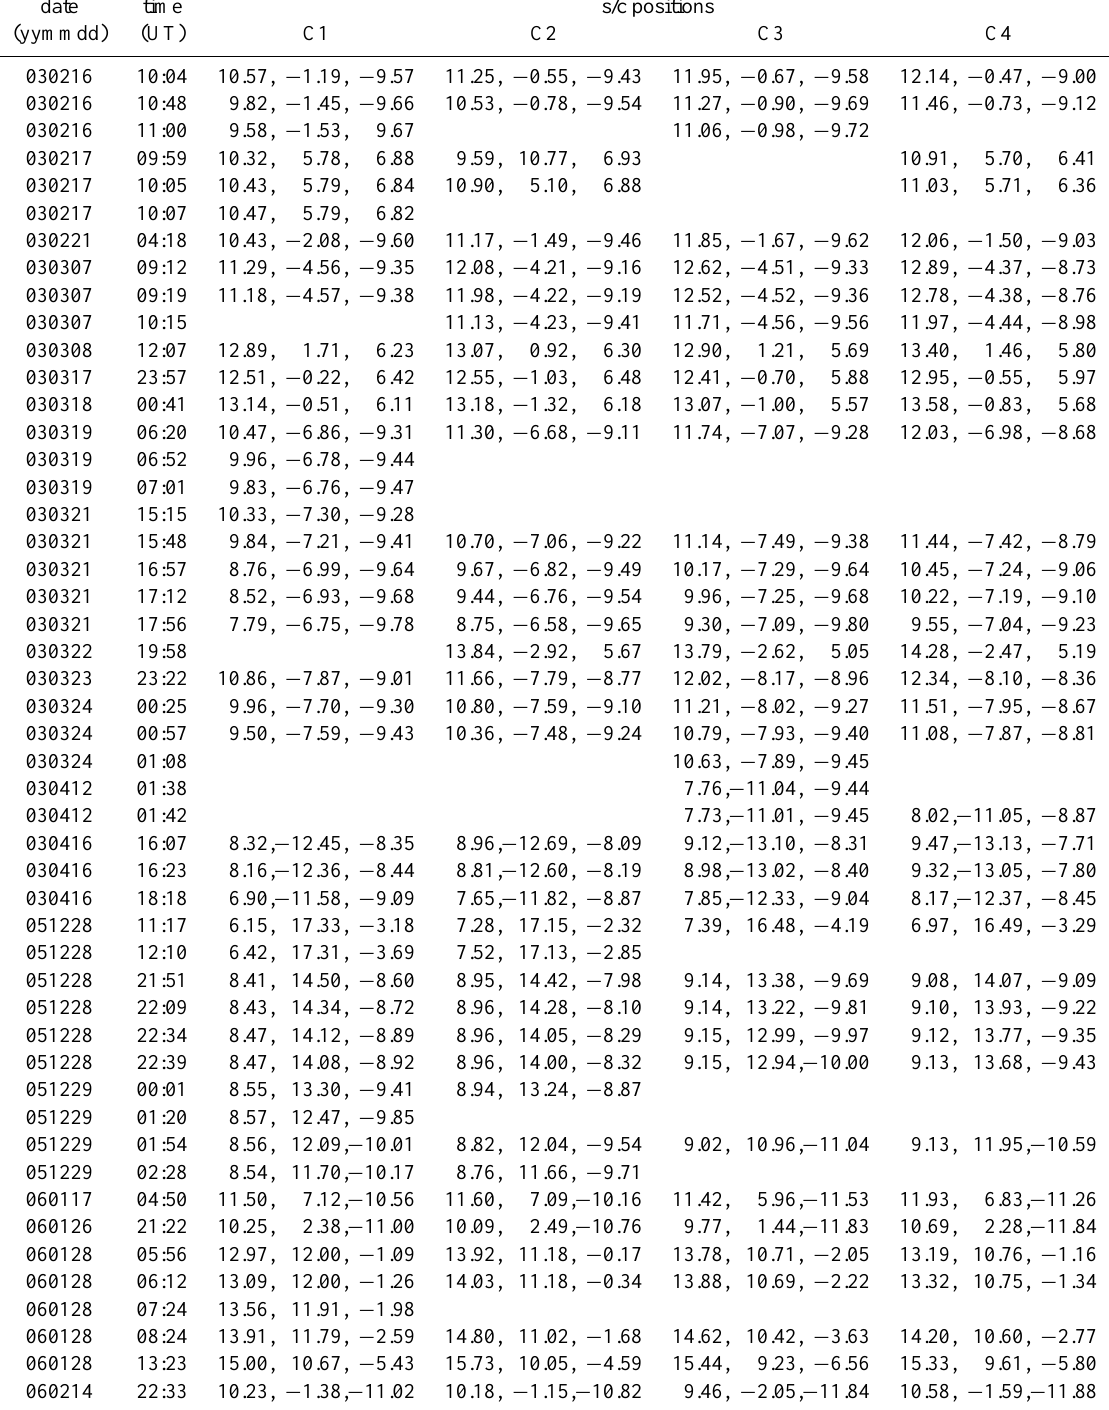
Table 1. The list of studied HFA events and spacecraft positions where HFA was observed in GSE system, in R Earth units. An empty cell indicates that the satellite in question did not observe the magnetic signature of a